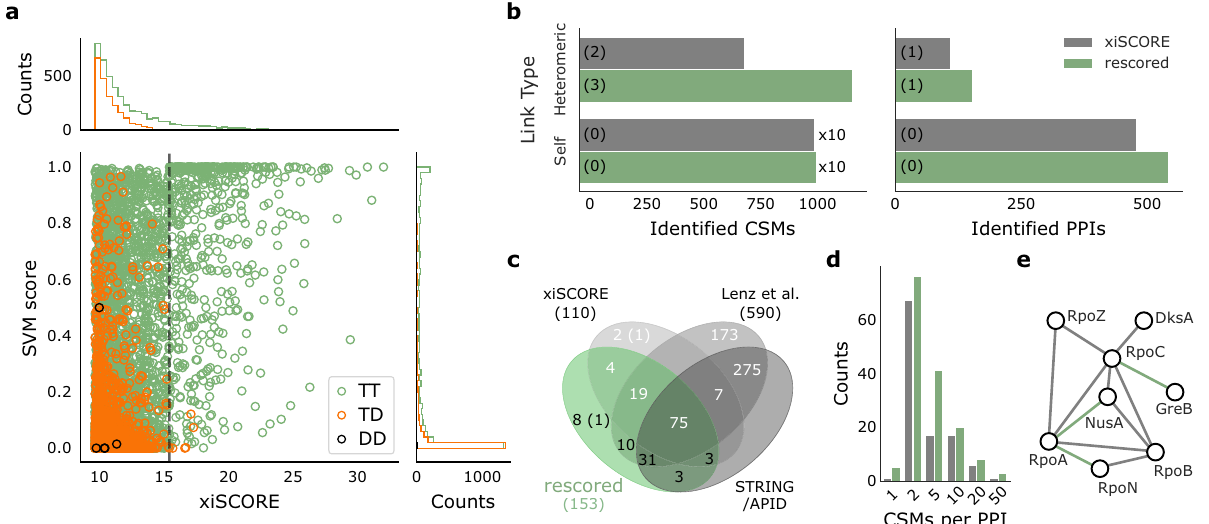
Fig. 4 Incorporation of RT prediction to CSM-scoring increases crosslink identi fi cation. a Score distributions of heteromeric CSMs based on mass spectrometric information (xiSCORE) and retention time features (SVM score). The dashed line indicates the xiSCORE-based CSM-FDR threshold of 1%. b Increase in the identi fi cation of TT-CSMs and PPIs at constant FDR. Numbers in brackets indicate identi fi cations involving a human protein. c Overlap of observed PPIs (at 1% heteromeric PPI-FDR) to external references. Numbers in the Venn diagram represent the identi fi ed PPIs among E. coli proteins or PPIs involving human proteins (in brackets). Black numbers highlight the added bene fi t from combining xiSCORE with xiRT ’ s SVM score for PPI identi fi cation. d Distribution of CSMs per PPI before (gray) and after CSM-rescoring (green). e Selected subnetwork of the RNA polymerase with PPIs only identi fi ed after the rescoring connected in green. Data in b – e correspond to a 1% PPI-FDR (pre fi ltered at a 5% CSM-FDR). Source data are provided as a Source Data fi Heteromeric CSMs increased 1.7-fold and heteromeric PPIs Likely, the bene fi ts of RT predictions for the rescoring depend increased 1.4-fold (Fig. 4b). Self-links increased only marginally on the data set and applied chromatographic separations. On the in agreement with their smaller search space and accordingly E. coli data, we, therefore, performed additional analyses where lower random match frequency. Essentially, nearly all self-links we limited the rescoring to only use a subset of the chromato- were identi fi ed exhaustively based on mass spectrometric data graphic dimensions (Supplementary Table 5). The number of alone. In contrast, RT information substantially improved the identi fi ed CSMs for heteromeric links increased from 724 in the identi fi cation of heteromeric CSMs. Further gains might be possible by directly combining RT features with mass spectro- metric features (and possibly also other) for supervised scoring.